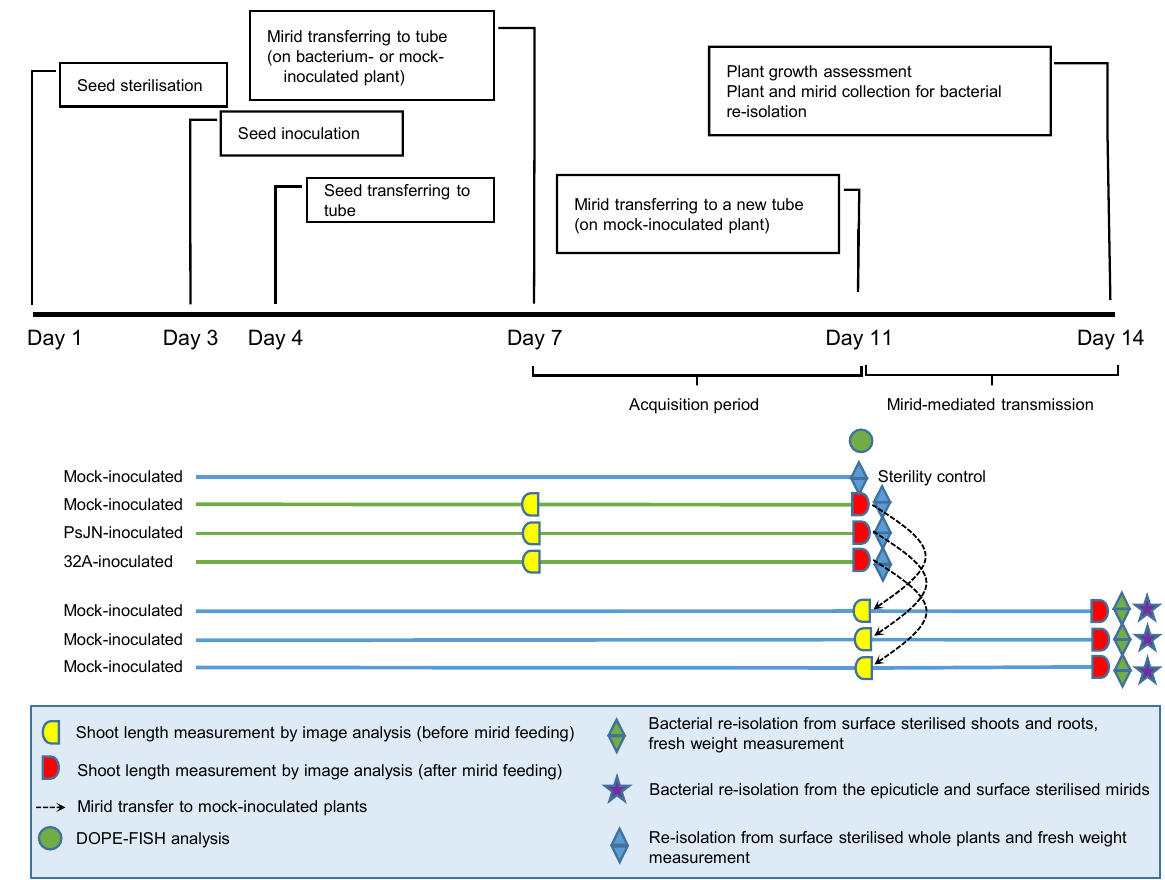
Figure 1. Description of the experiment. Day 1, surface-disinfected seeds were transferred to Petri dishes containing 1% water agar and were incubated in a growth chamber to allow seed germination. Day 3, seeds were treated with sterile MgSO 4 (mock-inoculated) or inoculated with a bacterial suspension of Paraburkholderia phytofirmans PsJN (PsJN) or Enterobacter sp. 32A (32A) by overnight incubation in the growth chamber. Day 4, germinated seeds with the same root length were selected and each seed was transferred to a sterile glass tube containing half-strength Hoagland. Day 7, a freshly emerged mirid adult ( Macrolophus pygmaeus or Nesidiocoris tenuis ) was placed in each glass tube containing a tomato plant that was either mock-inoculated or inoculated with PsJN or 32A. Before transferring the mirid in the glass tube, shoot length was measured by image analysis. Tubes were incubated in the growth chamber in order to allow mirids to feed on tomato plants (acquisition period). Day 11, for double labelling of the oligonucleotide probes for fluorescence in situ hybridisation (DOPE-FISH) analysis, mirids were collected at the end of the acquisition period on mock-inoculated plants or plants inoculated with PsJN or 32A, shoot length was measured by image analysis, and whole plants were collected for bacterial re-isolation and fresh weight assessment. Each mirid was transferred to a new glass tube containing a mock-inoculated tomato plant and incubated to allow the mirids to feed on the tomato plants (mirid-mediated transmission), and then shoot length was measured. Day 14, mirids and plants after mirid-mediated transmission were collected for bacterial re-isolation, and the tomato shoot length and fresh weight were assessed.